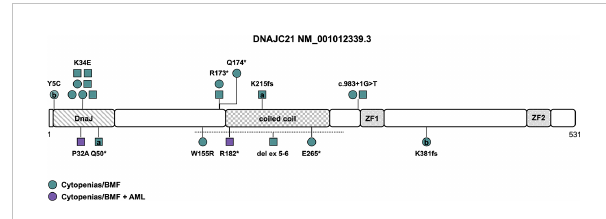
FIGURE 3 Schematic of the DNAJC21 transcript (NM_001012339.3) and its protein domains with the location of all reported germline variants. Circles represent females and squares represent males. Symbols on the same horizontal level are individuals from the same family. Letters within the symbols indicate individuals with compound heterozygous genotype, while symbols without letters indicate homozygosity for the variant. The color fi ll depicts different phenotypes. The dotted line shows the location of the sole described copy number variant. AML, acute myeloid leukemia; BMF, bone marrow failure; ZF, zinc fi